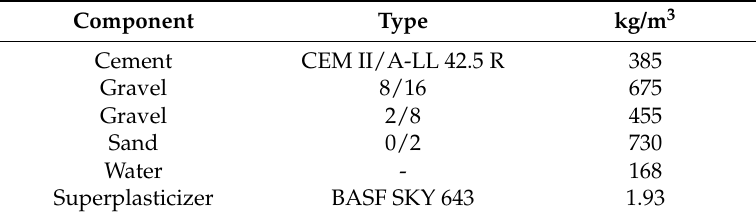
Table 1. Concrete composition used for the reinforced concrete (RC) beam.